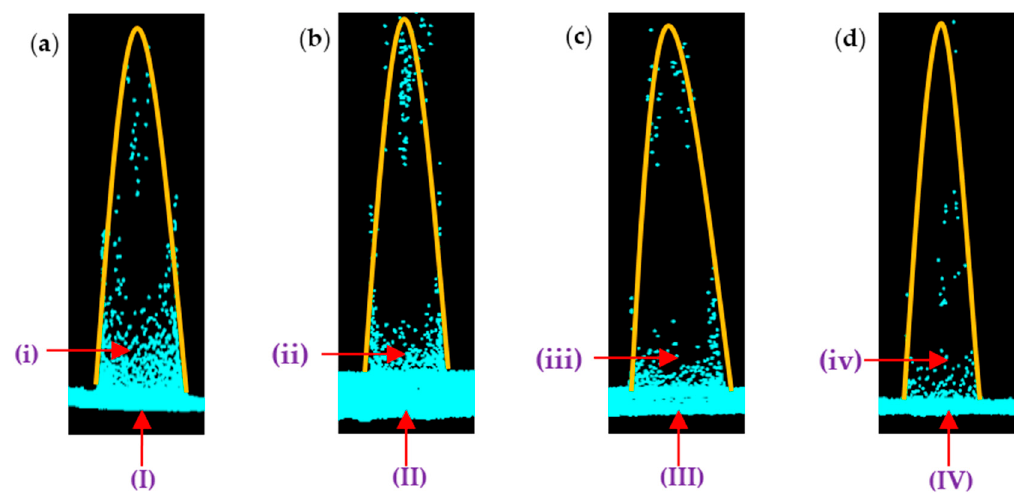
Figure 3. Original intensity images created by Faro SCENE 4.8: ( a ) computer screen; ( b ) ceramic tile; ( c ) iron sheet; ( d ) polyethylene panel. Specular highlight phenomena (bright regions) are present on all targets.